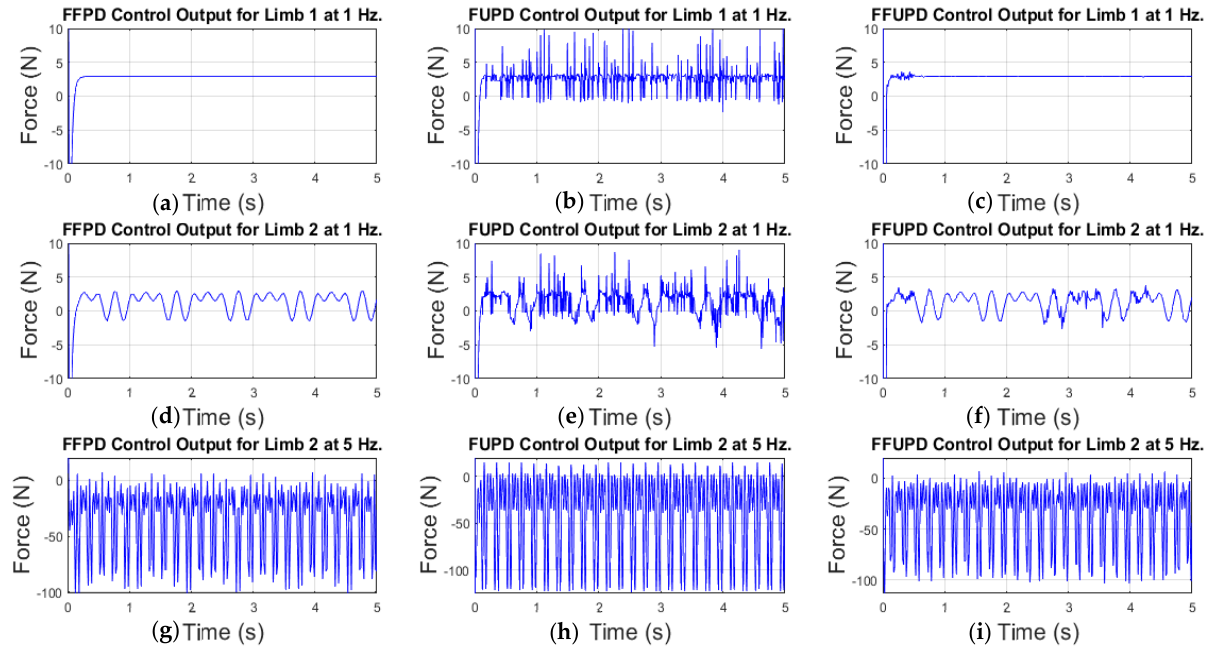
Figure 12. Control action taken from controllers for: ( a – c ) limb 1 at 1 Hz, ( d – f ) limb 2 at 1 Hz and ( g – i ) limb 2 at 5 Hz.